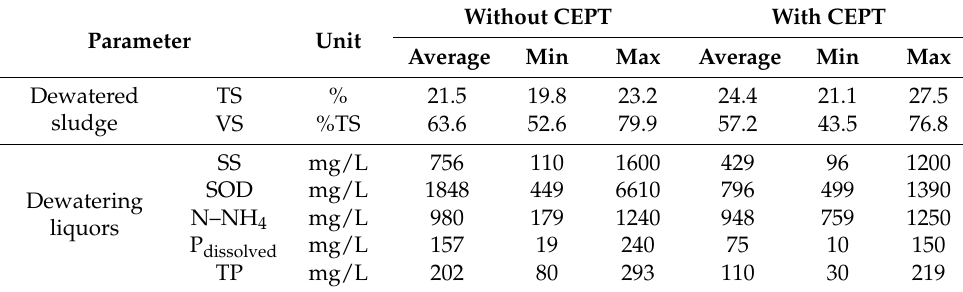
Table 4. Dewatered sludge and dewatering liquors